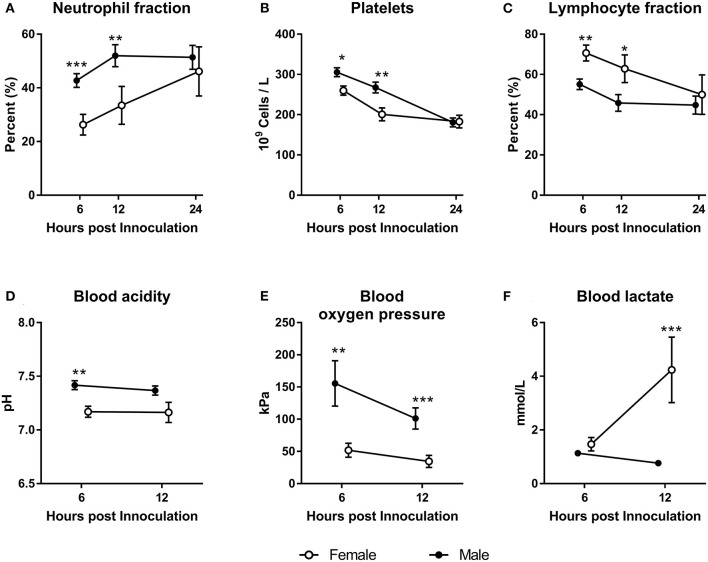
Hematological and blood gas parameters in female and male preterm pigs (open and filled circles, respectively) inoculated with live S. epidermidis bacteria shortly after birth. Neutrophil fractions (A, n = 38). Platelet counts (B, n = 38). Lymphocyte fractions (C, n = 38). Blood acidity (D, n = 38). Blood oxygen pressure (E, n = 38). Blood lactate levels (F, n = 38). All shown as means with corresponding SE. *P < 0.05, **P < 0.01, ***P < 0.001.